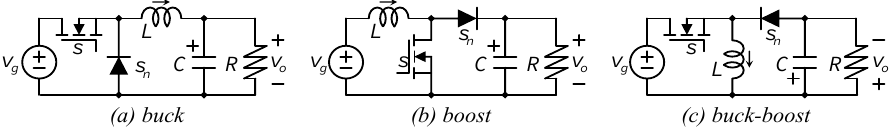
Figure 1. The basic family of second-order converters: ( a ) buck, ( b ) boost, and ( c ) buck-boost converters. There is also a fourth order (FO) family, with members such as the Cuk, SEPIC (Single-ended primary-inductor), Zeta, etc. [1]. Figure 2 shows certain members of the FO converters family. The FO family of converters also has a fourth-order buck and a fourth-order boost. Sometimes, this last is called the super-boost converter